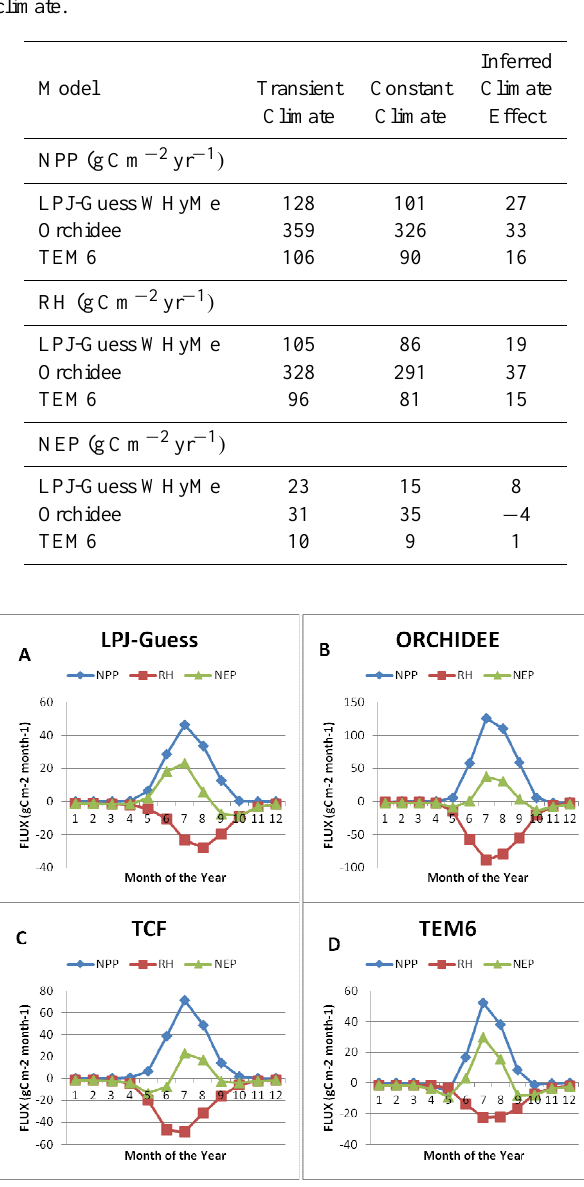
Fig. 3. Mean monthly fluxes of gross primary production (GPP), net primary production (NPP), heterotrophic respiration (RH), and net ecosystem production (NEP) simulated by LPJ-Guess WHyMe (Panel A ), Orchidee (Panel B ), and TEM6 (Panel D ) between 1990 and 2006 and by TCF (Panel C ) between 2000 and 2009.